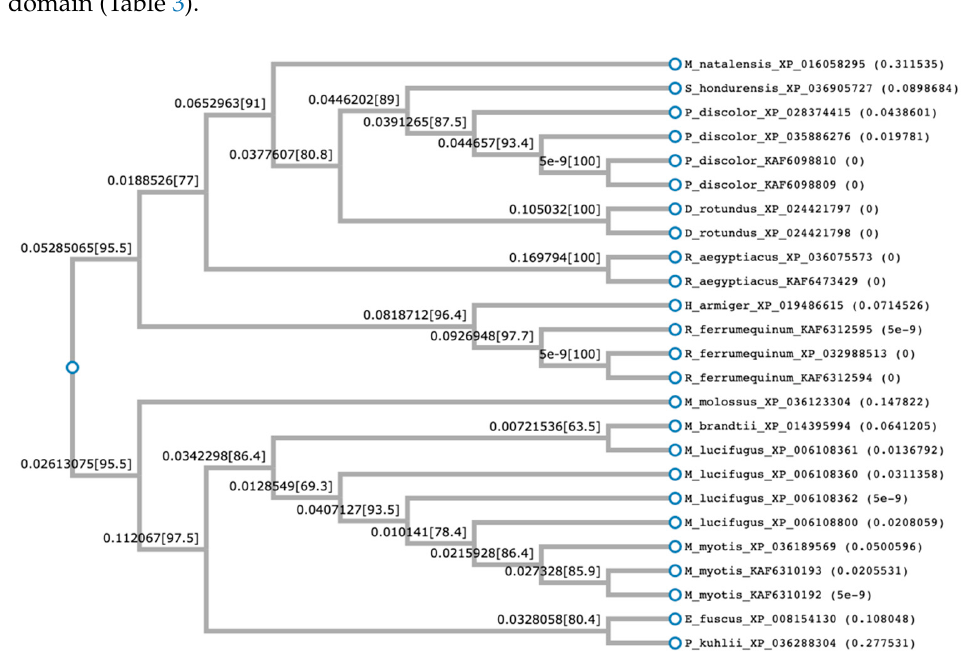
Figure 2. Phylogenetic tree constructed from the multi-sequence alignments of the conserved cathelin region of bat cathelicidins. The tree was constructed using FastTree with default parameters. FastTree infers maximum-likelihood phylogenetic trees using the Neighbor Joining method and computes local support values with the Shimodaira-Hasegawa